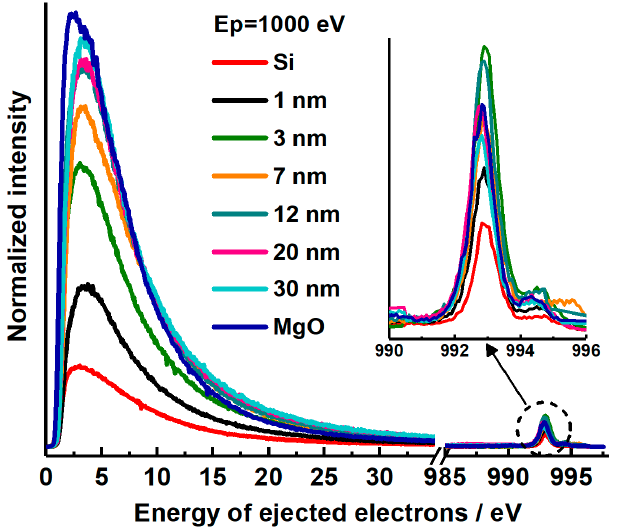
Figure 6. Secondary electron energy spectrum of MgO/Si double-layer